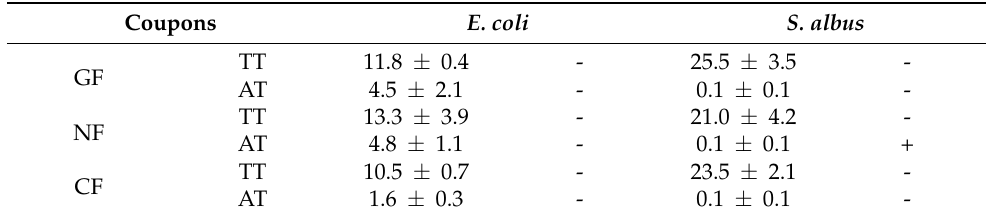
Table 1. Bacteriostatic bands of GF, NF and CF to E. coli and S. albus (units: mm). Coupons E. coli S. albus TT GF AT NF